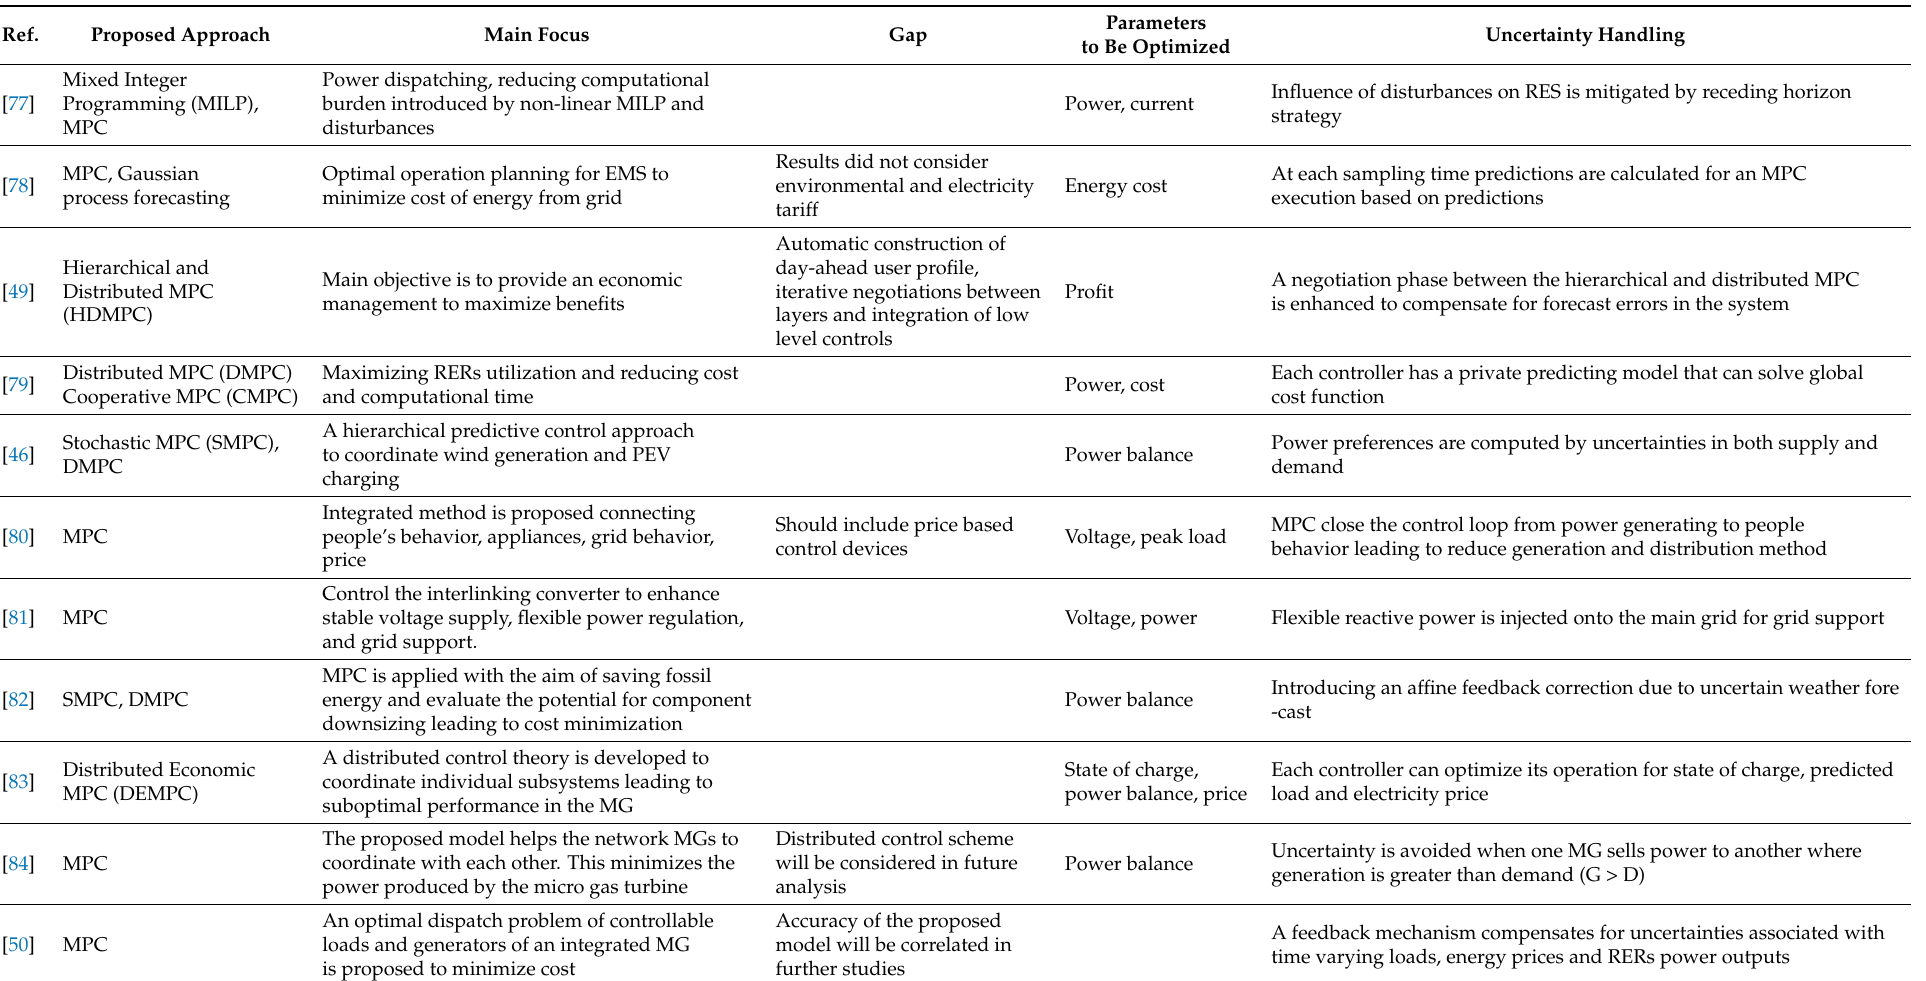
Table 2. Summary of recent MPC applications to grid-connected